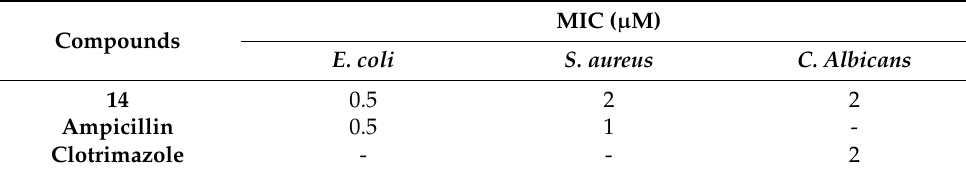
Table 3. The MIC of OSe compound 14